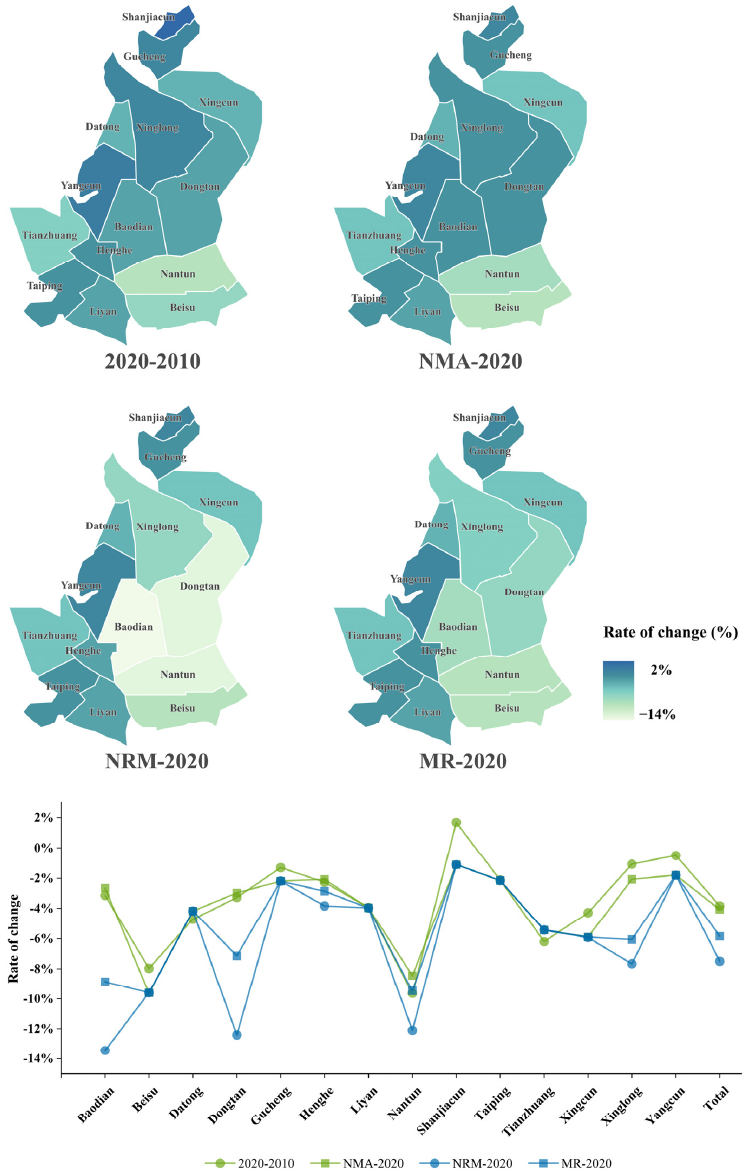
Figure 8. Rate of change of total carbon storage of different mines in different periods.